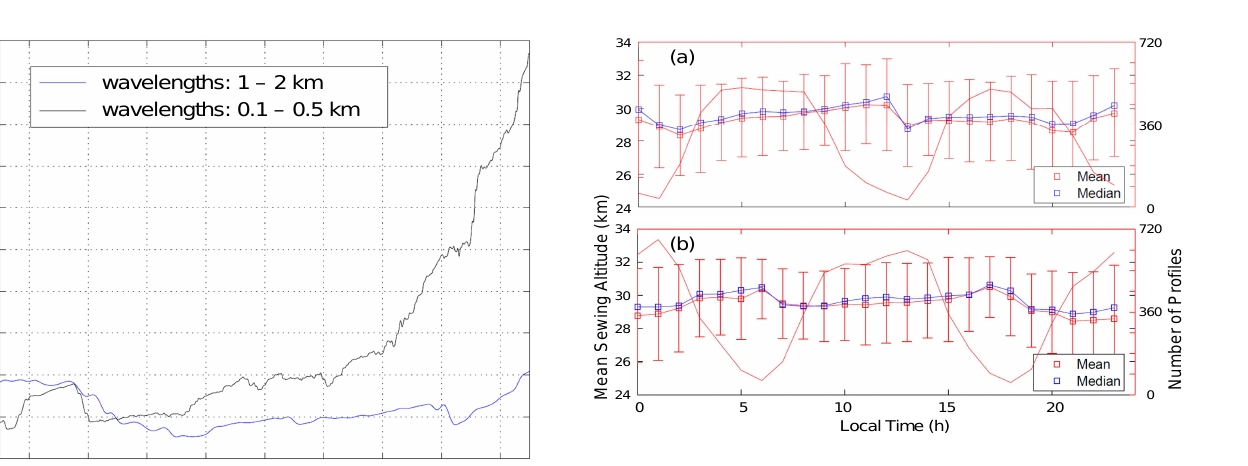
Fig. 9. Local time distribution of the mean (red square) and (blue square) median sewing altitude (left scale) together with the stan- dard deviation at 20 ◦ S–20 ◦ N in (a) November 2006 and (b) De- cember 2006. The red line indicates the number of profiles (right